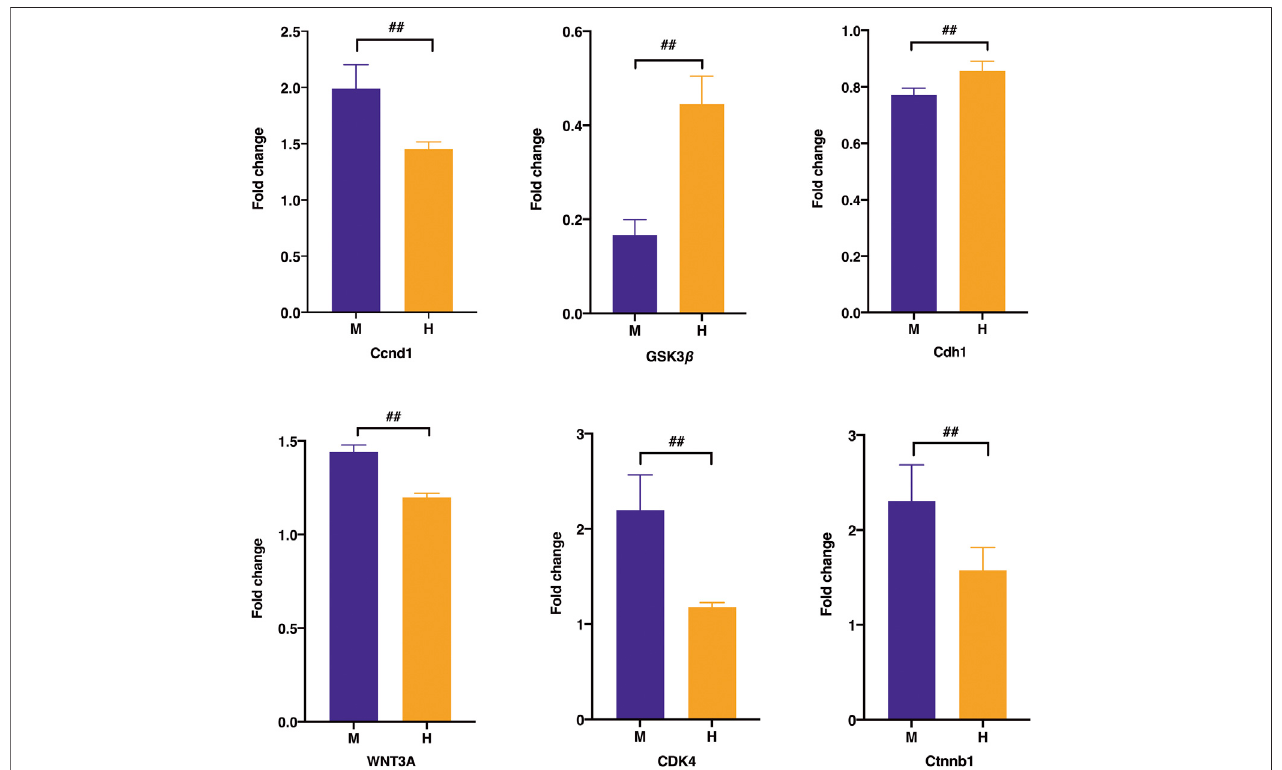
FIGURE 11 | Effect of HQT on mRNA expression levels of the corresponding genes according to real-time PCR analysis. Data are represented as the mean ± SD ( n = 5, (cid:1) x ± s ). * p < 0.05, ** p < 0.01 vs. normal control; # p < 0.05, ## p < 0.01 vs model control. C: normal control; M: model control; H: HQT control.